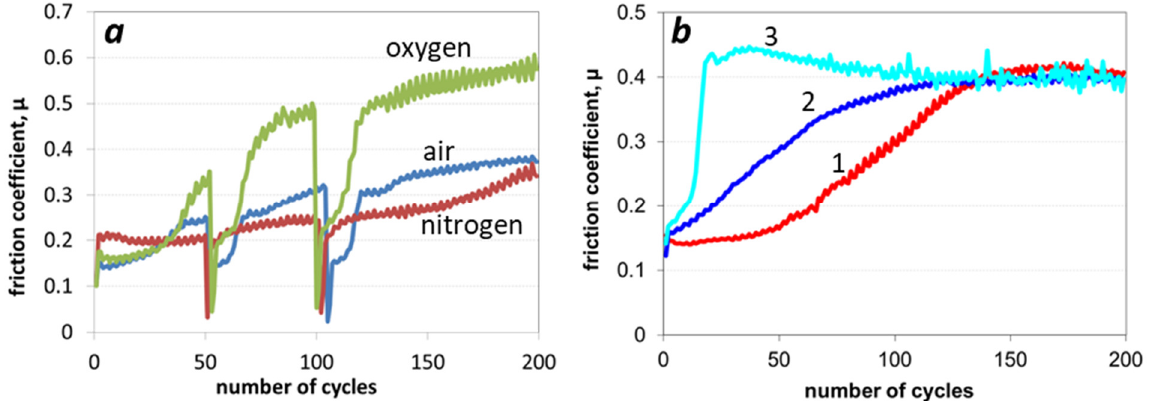
Figure 12. ( a ) The sliding test on sputter-deposited TiN coating was interrupted after 50 laps for 30 min and then continued using same conditions. After sliding test was continued, different friction development was observed in the three studied atmospheres. ( b ) The running-in period depends on the state of coating and ball surfaces: the sliding test was performed in ambient air on the fresh coating surface and a new spot on the alumina ball (1); on the worn ball surface and a new track on the coating surface (2); on a new spot on the alumina ball and the track formed on the coating sur- face during the previous test